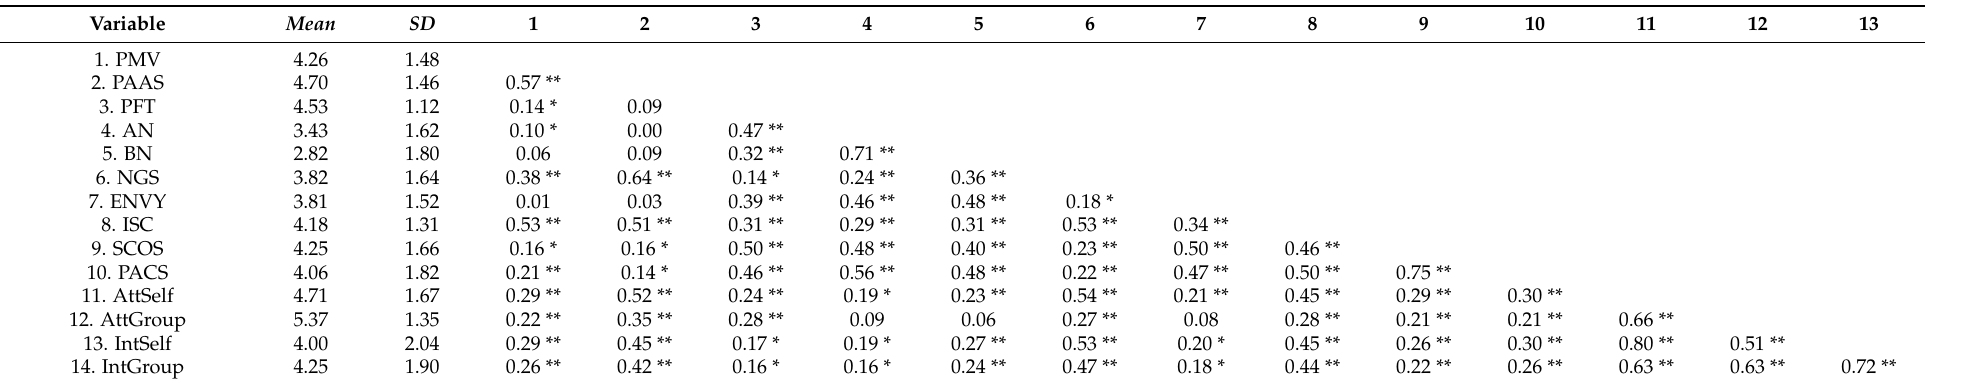
Table 7. Study 3: Means, standard deviations (SDs), and correlations (Pearson’s parametric correlation) of variables ( N = 357).